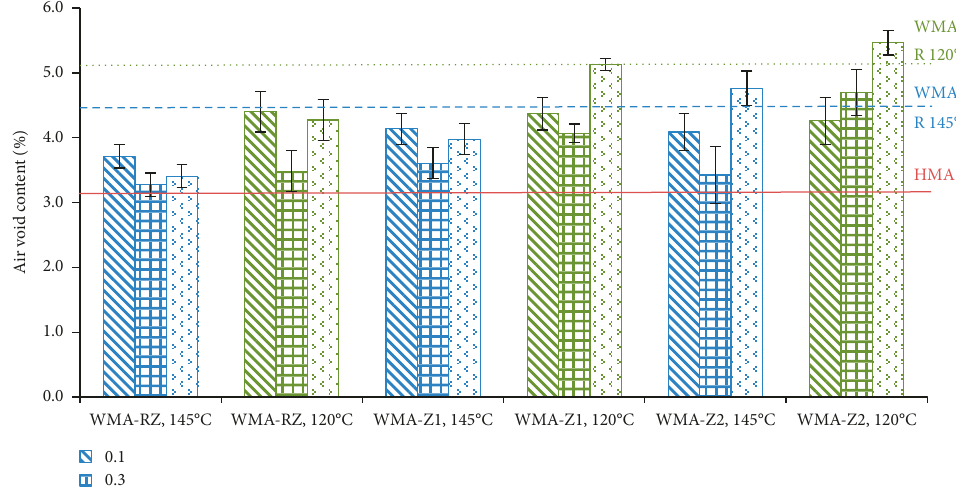
Figure 3: Influence of zeolite dosage and type on WMA workability and compactibility.